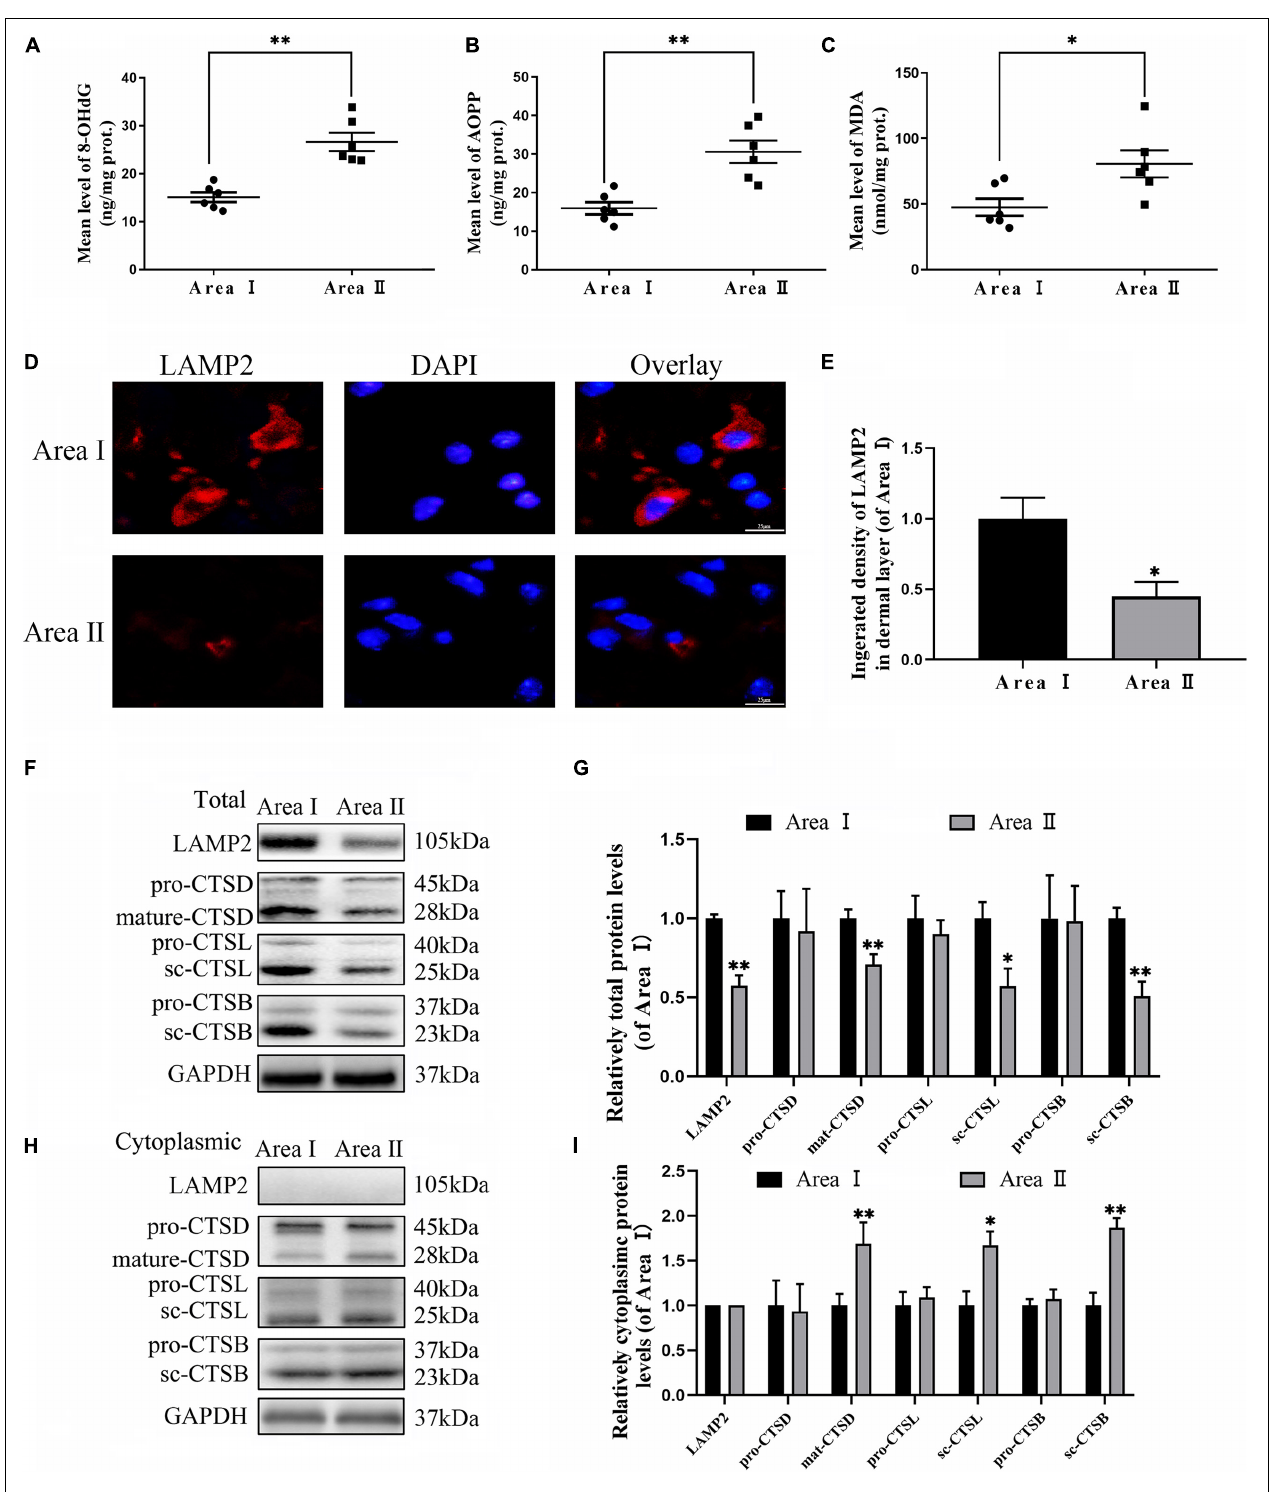
FIGURE 3 | Accumulation of ROS and lysosomal dysfunction exists in random flaps. (A–C) ELISA of MDA 8-OHdG and AOPP and in flap tissue from area II and area I. (D) Immunofluorescence for LAMP2 in skin flaps (scale bar: 25 mm). (E) The fluorescence intensity for LAMP2. (F,H) Western blotting of the lysosome function-related proteins CTSD, LAMP2, CTSB, and CTSL in total protein and cytoplasmic protein (isolating lysosomal protein). (G,I) Quantification of CTSD, LAMP2, CTSB, and CTSL immunoblots. Values represent the mean ± SEM, n = 6 per group. * p < 0.05 and ** p < 0.01, vs. area I group.